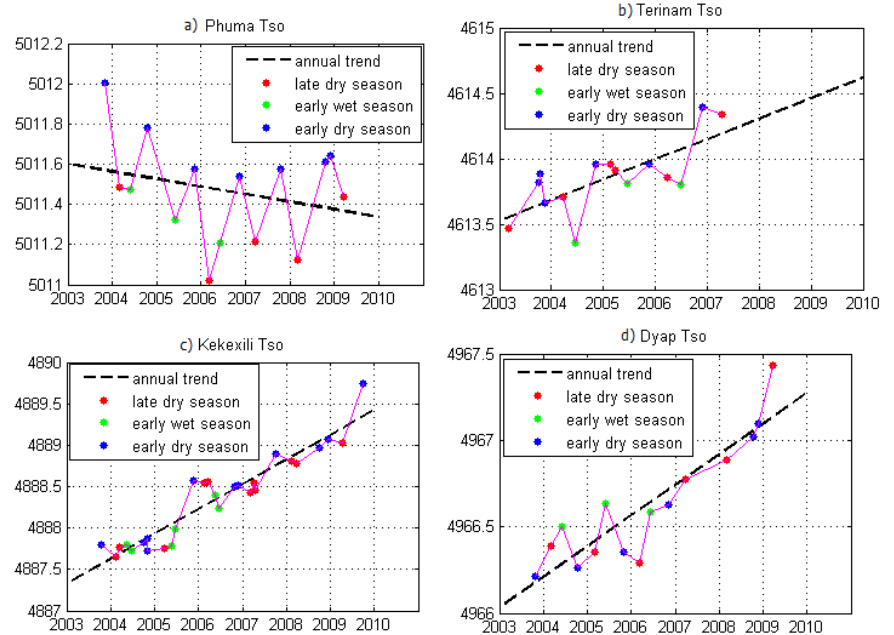
Figure 5. Typical seasonal lake level variations at selected lakes in sub-areas on the Tibetan plateau between 2003 and